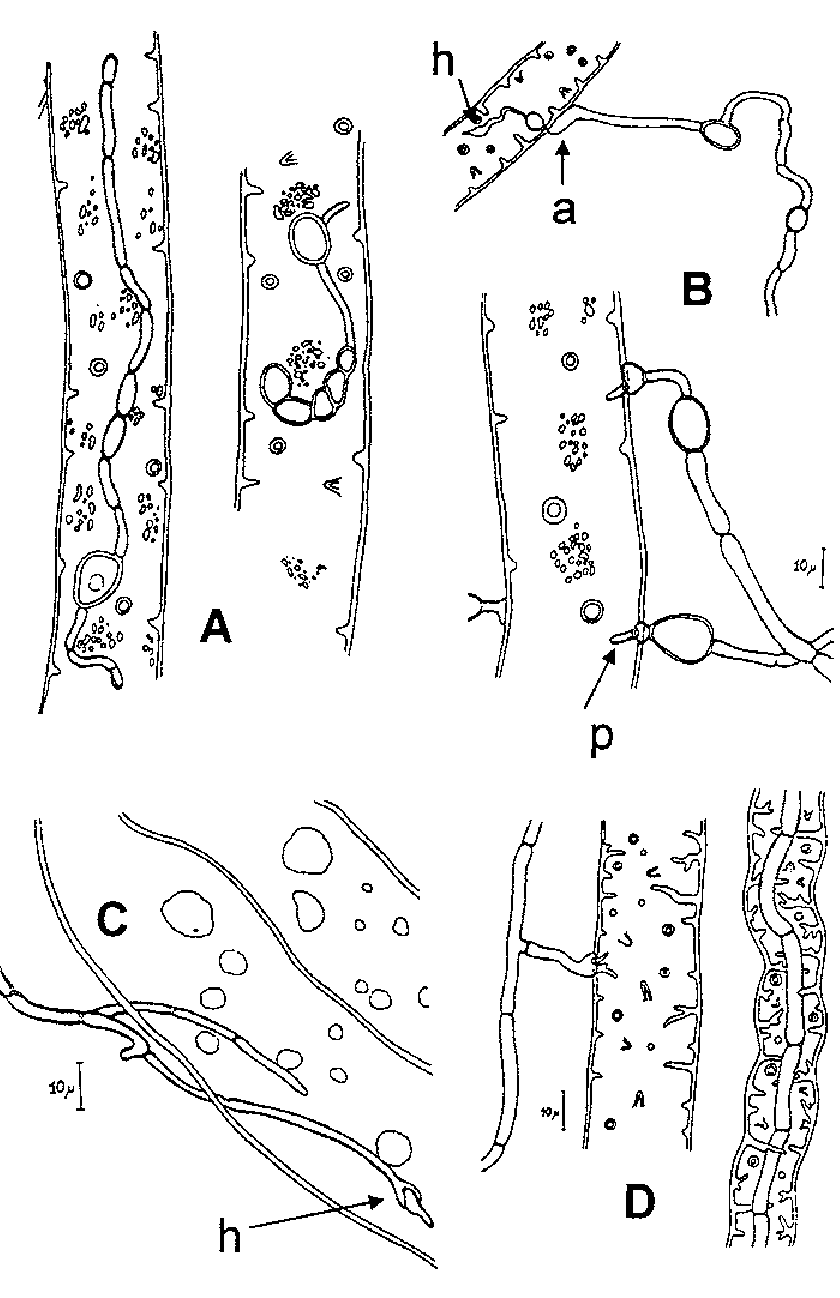
Fig. 1: A C) Loreleia marchantiae (= daamsii ) and D) Loreleia postii (cf. marchantiae ) in confrontation with Marchantia : A) hyphae within rhizoids of Marchantia ; B) appressoria (a), haustoria (h), penetrating hyphae (p) formed in contact with tuberculate rhizoids of March antia ; C) haustorium (h) in a cell of Marchantia ; D) mycelium penetrating a rhizoid (left side) and within a rhizoid (right side) of